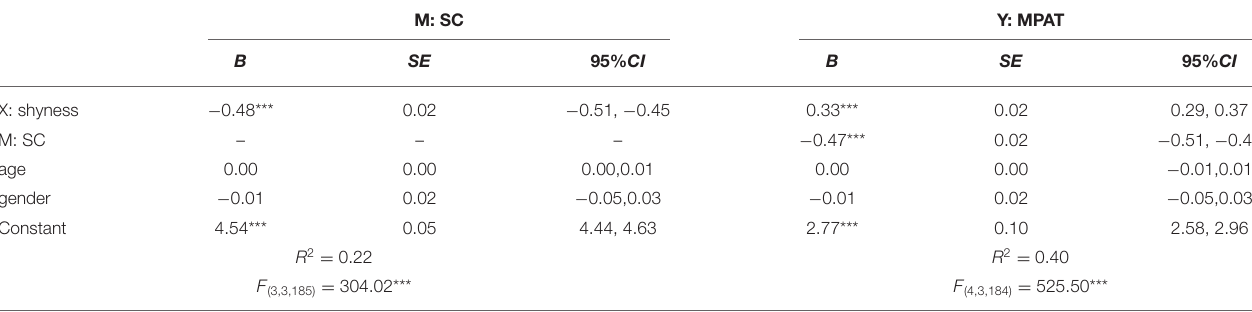
TABLE 4 | Results of mediation analysis of